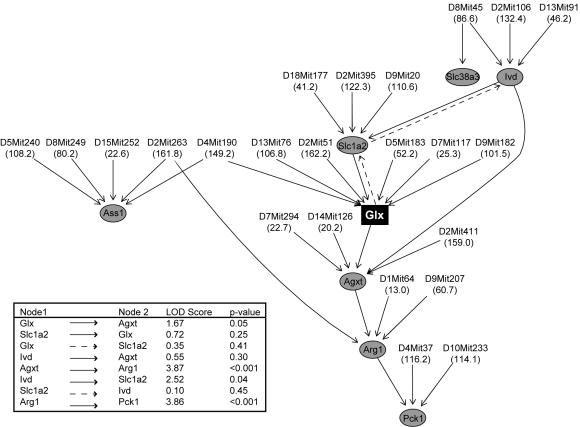
Glx network.This network consists of a select number of transcripts (grey circles) among the 250 mRNA that are most correlated to glx (black rectangle) (p<0.002). The microsatellite marker (Mb) for peak eQTL or mQTL altering levels of transcripts and metabolites, respectively, are given. For any two phenotypes connected by an edge, the direction LOD score and p-value are indicated (insert). The best solution was determined by an approximate Bayes factor (BF) and indicated in solid lines, the second best solution in dotted lines.